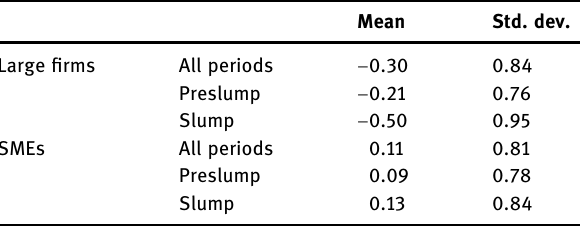
Table 4: Financial costs ( deviations with respect to the mean ) for SMEs versus large fi rms during the preslump and slump periods Mean Std.